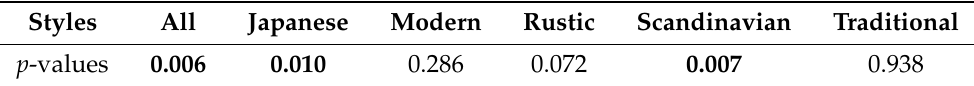
Table 4. Welch’s t -test results for F - measure